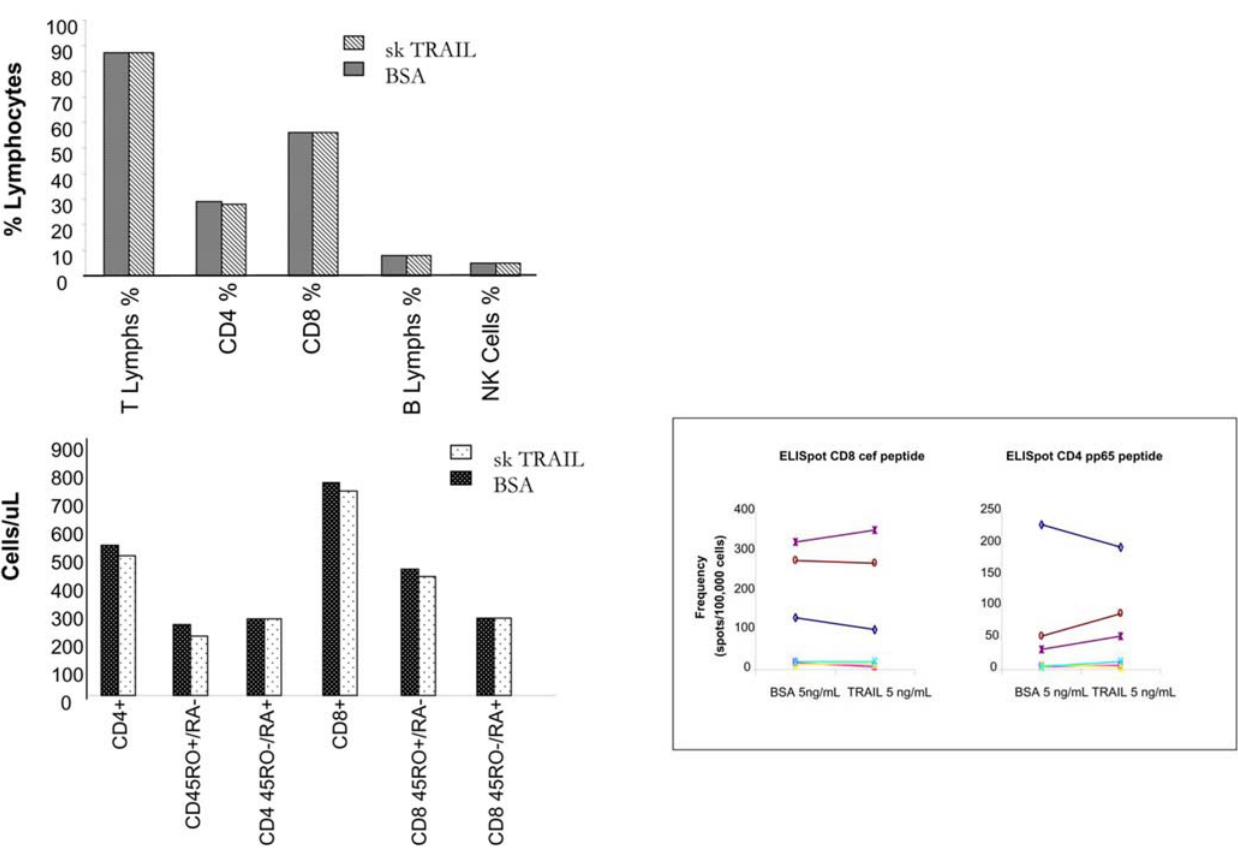
Figure 5. Exogenous superkiller TRAIL does not cause deleterious effects on immune cell numbers or function. PBLs from HIV infected subjects were cultured with skTRAIL or BSA and analyzed for percent of T, B and NK cells (A, top panel), and percent CD4 + and CD8 + memory and naı¨ve T cells (A, bottom panel) by flow cytometry. Cultured PBLs were also analyzed for CD4 and CD8 recall responses by ELISPOT (B).